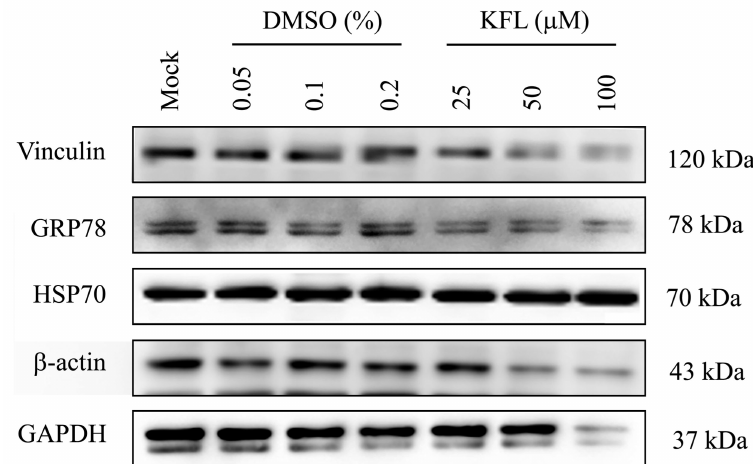
Figure 6. Evaluation of protein expression after kaempferol treatment. BHK-21 cells were treated with di ff erent concentrations of kaempferol or DMSO vehicle control for 24 h after which expression of vinculin, GRP78, Hsp70, β -actin and GAPDH was determined by western blotting using appropriate antibodies.